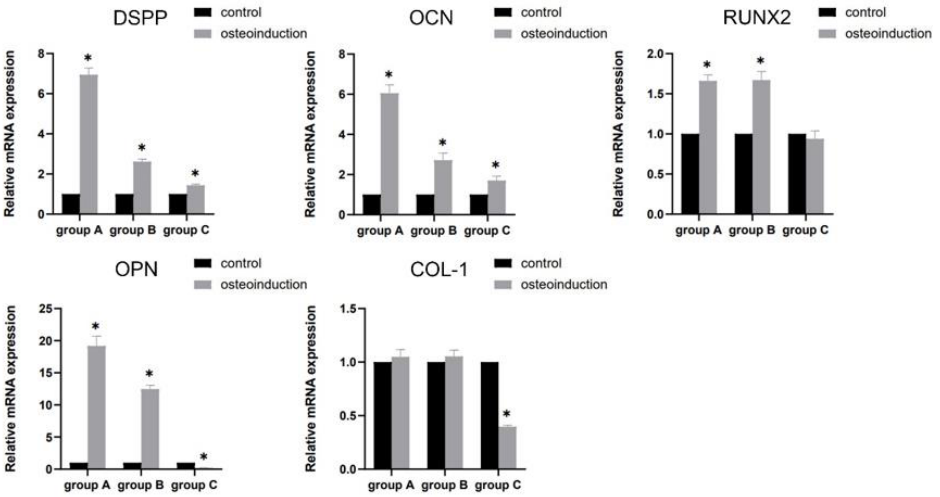
Figure 5. The mRNA expression of DSPP, OCN, RUNX2, OPN, and COL-1 after osteogenic induction for 7 days. * p < 0.05, versus control.